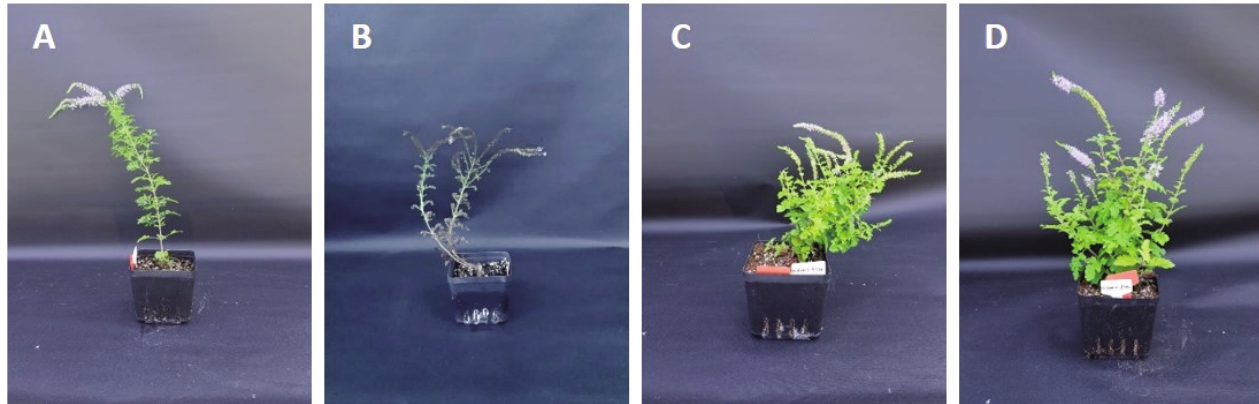
Fig. 3 ­ Growth and flowering characteristics in pinching and BA application groups 10 weeks after treatment. A) Control. B) Pinching. C) BA 500 ppm 0 week after pinching. D) BA 1000 ppm 0 week after